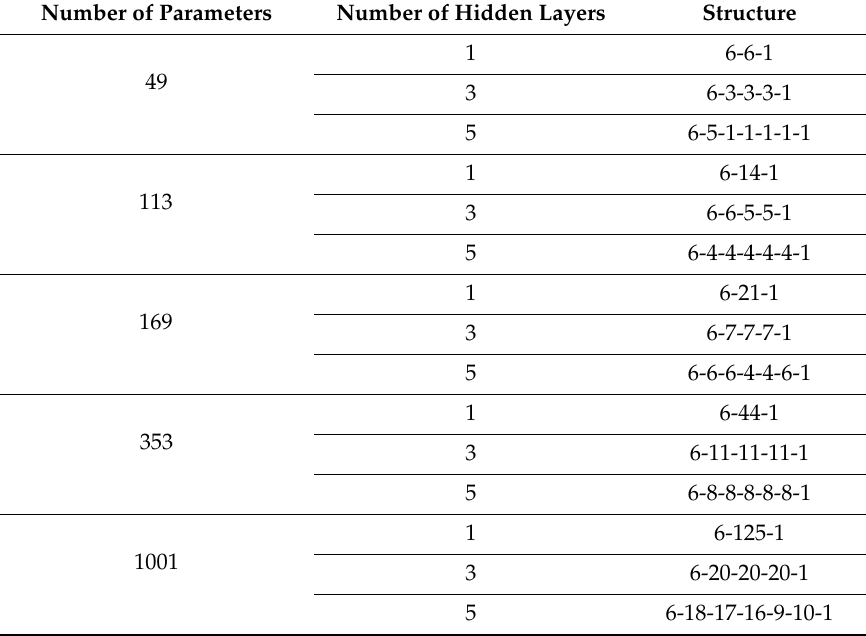
Figure 2. Schematic of the artificial neural network (ANN) with the total parameter number of 49 corresponding to ( a ) 1 hidden layer; ( b ) 3 hidden layers; and ( c ) 5 hidden layers.